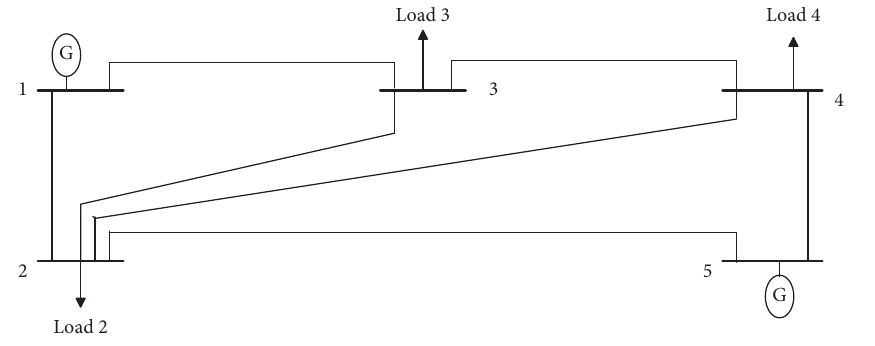
Figure 3: Single line diagram of an IEEE 5-bus System.